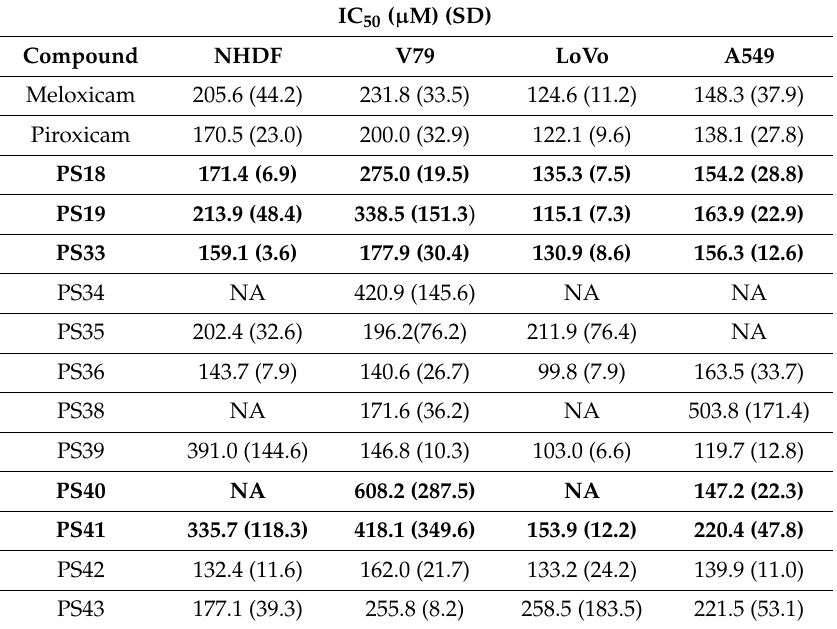
Table 3. Normal human dermal fibroblast (NHDF), LoVo and V79 IC 50 (SD) values for the studied compounds (mean (SD); n = 3).